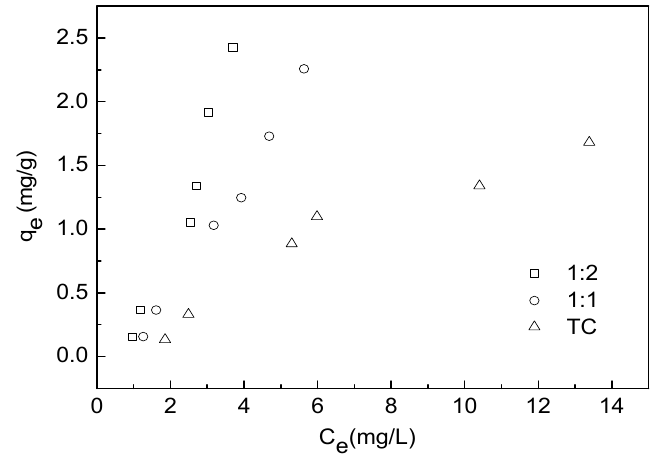
Figure 6. Adsorption isotherms of different TC-Cu complexs onto water hyacinth roots. Adsorption data of TC were fitted by three adsorption isotherm models as seen in Figure